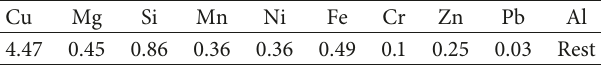
Table 1: Chemical composition of 2017A aluminum alloy (wt.%).